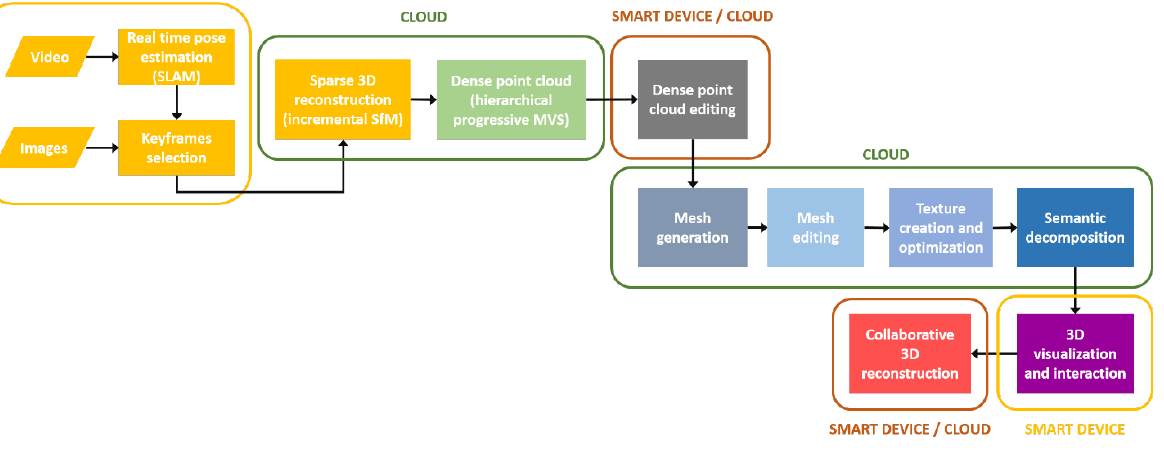
Figure 2: Detail workflow and functions of REPLICATE among Cloud and smart device.